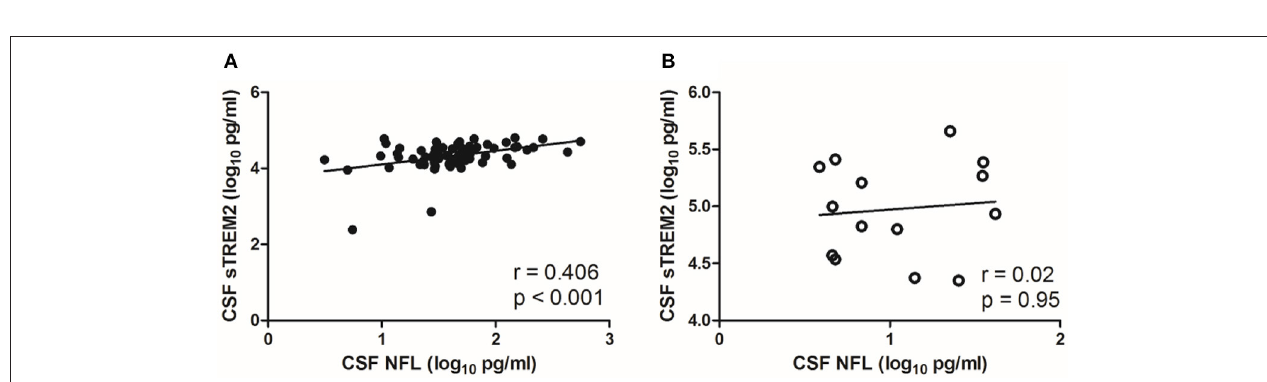
FIGURE 2 | Correlations between CSF sTREM2 and CSF NFL in NS group and syphilis/non-NS group. (A) CSF sTREM2 (log 10 pg/ml) levels were moderate correlated with CSF NFL (log 10 pg/ml) in NS group. (B) No significant correlation was found between CSF sTREM2 (log 10 pg/ml) and CSF NFL (log 10 pg/ml) in syphilis/non-NS group. NS, neurosyphilis; CSF, cerebrospinal fluid; sTREM2, soluble triggering receptor expressed on myeloid cells 2; NFL, neurofilament light